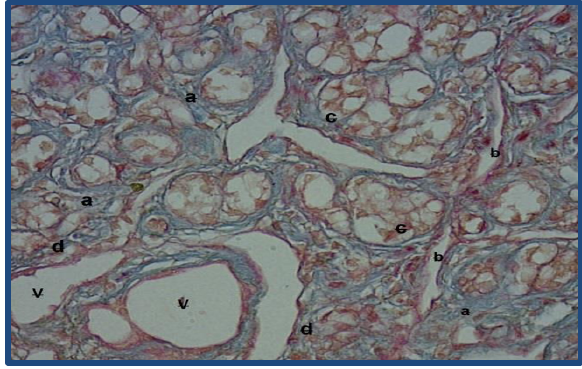
Figure, 5: Thyroid gland showed: a-Collagenous capsule b- Parathyroid nodule under the capsule c- Adipose tissue at the external part of the gland (Masson trichrome stain, 20 X).